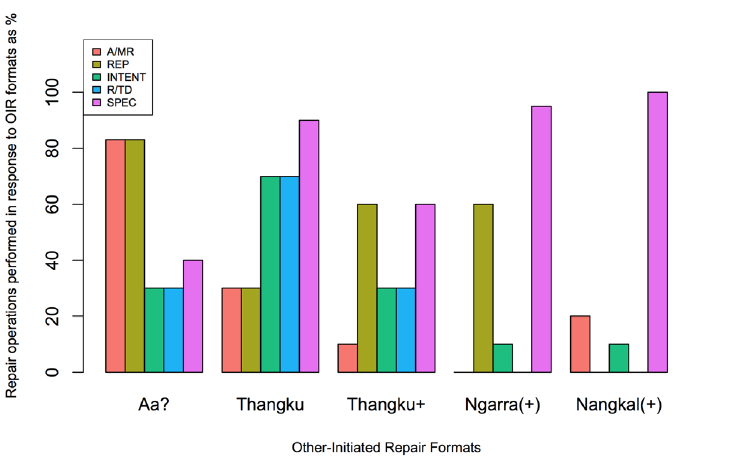
Figure 3: Grouped bar plots showing the types of repair operations performed in response to particular OIR formats. With regard to the restricted formats, as expected, ngarra (“where”) and nangkal (“who”) are overwhelmingly used for referential specification. However, a few tokens also clarified intended meanings and helped with misaligned recipiency. Thangku + also pushes for referential specification. However it is equally likely to produce repetition of trouble source items.18 In the open formats, audibility and misaligned recipiency are closely correlated with full or partial repetition of the trouble source turn.19 Aa? and thangku deal with the same range of problems so have overlapping functional loads. However Aa? is more coercive of audibility and recipiency alignment operations than thangku . Both seek elaboration on speakers’ intentions, attend to relevance issues and topical disjuncture, and result in referential specifications; yet thangku is far more coercive in these respects than Aa? . Effectively, the two open RI formats are biased pragmatically in different directions. That the interjection surfaces more often than the question word probably reflects these differences in pragmatic bias.